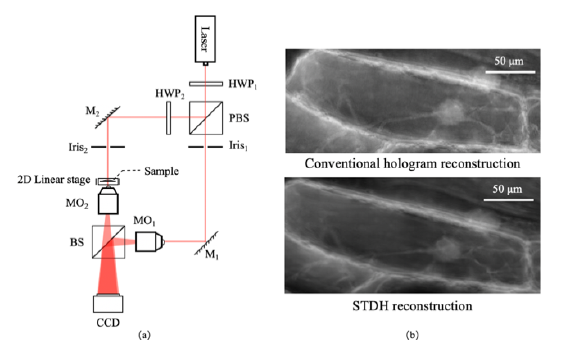
Fig. 2. STDH recording and reconstruction of onion epidermal cells. (a) experimental setup; (b) phase reconstruction results, the upper image is from conventional hologram, the lower image is from